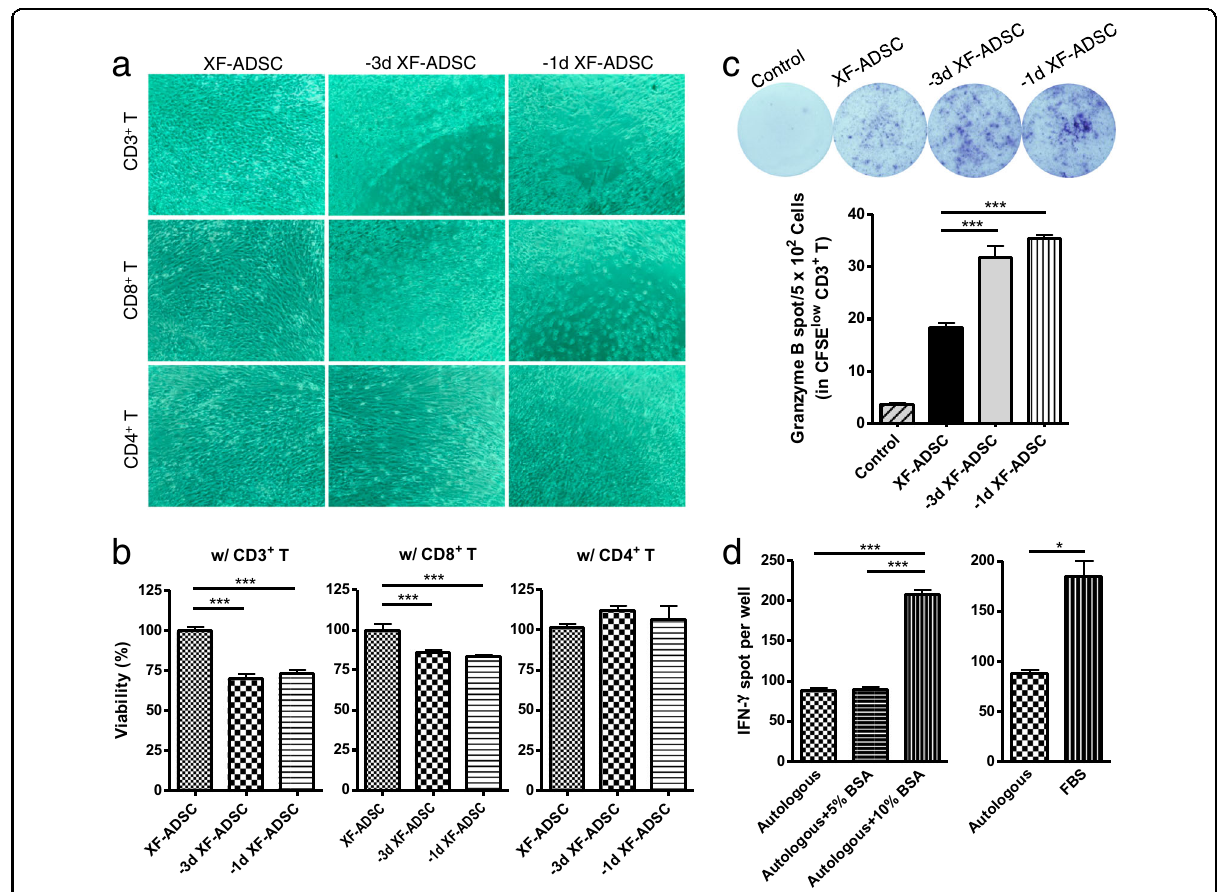
Fig. 2 Pre-exposed adipose-derived mesenchymal stem cells (ADSCs) increase cytotoxicity through CD8 T-cell granzyme B production with increasing reaction times. a ADSCs previously exposed to xenogeneic serum were subjected to allogeneic antigen stimulation for 14 days in xeno-free medium containing 5% autologous serum. Pre-exposed ADSCs were reacted with each T cell type, and the cell viability was evaluated in comparison with that of ADSCs grown in xeno-free medium (XF-ADSCs), which were cultured in xeno-free medium immediately after isolation from adipose tissue. b Graphical representation of ADSC viability corresponding to ( a ) ( n = 12 (each for CD3 T and CD8 T), n = 6 (CD4 T)). c Spots of granzyme B secreted by CD3 T cells were analyzed by enzyme-linked immunospot (ELISPOT) analysis ( n = 3 for each sample). d CD3 T cells and T cell- depleted peripheral blood mononuclear cells (Td-PBMCs) were cultured in medium containing 5% autologous serum, bovine serum albumin (BSA) or fetal bovine serum (FBS) for 21 days. To examine the effect of xenogeneic antigens, the production of interferon- γ (IFN- γ ) by T cells was analyzed by ELISPOT ( n = 6 (autologous), n = 3 (each for BSA and FBS)); * p < 0.05; *** p <